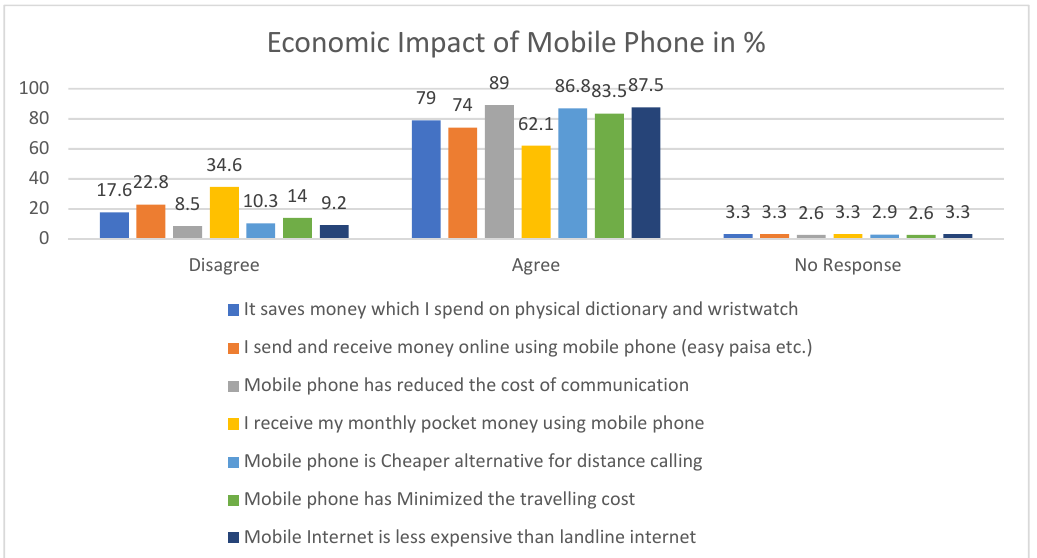
Figure 7. Economic impact of mobile phone use in the lives of young people of GB.